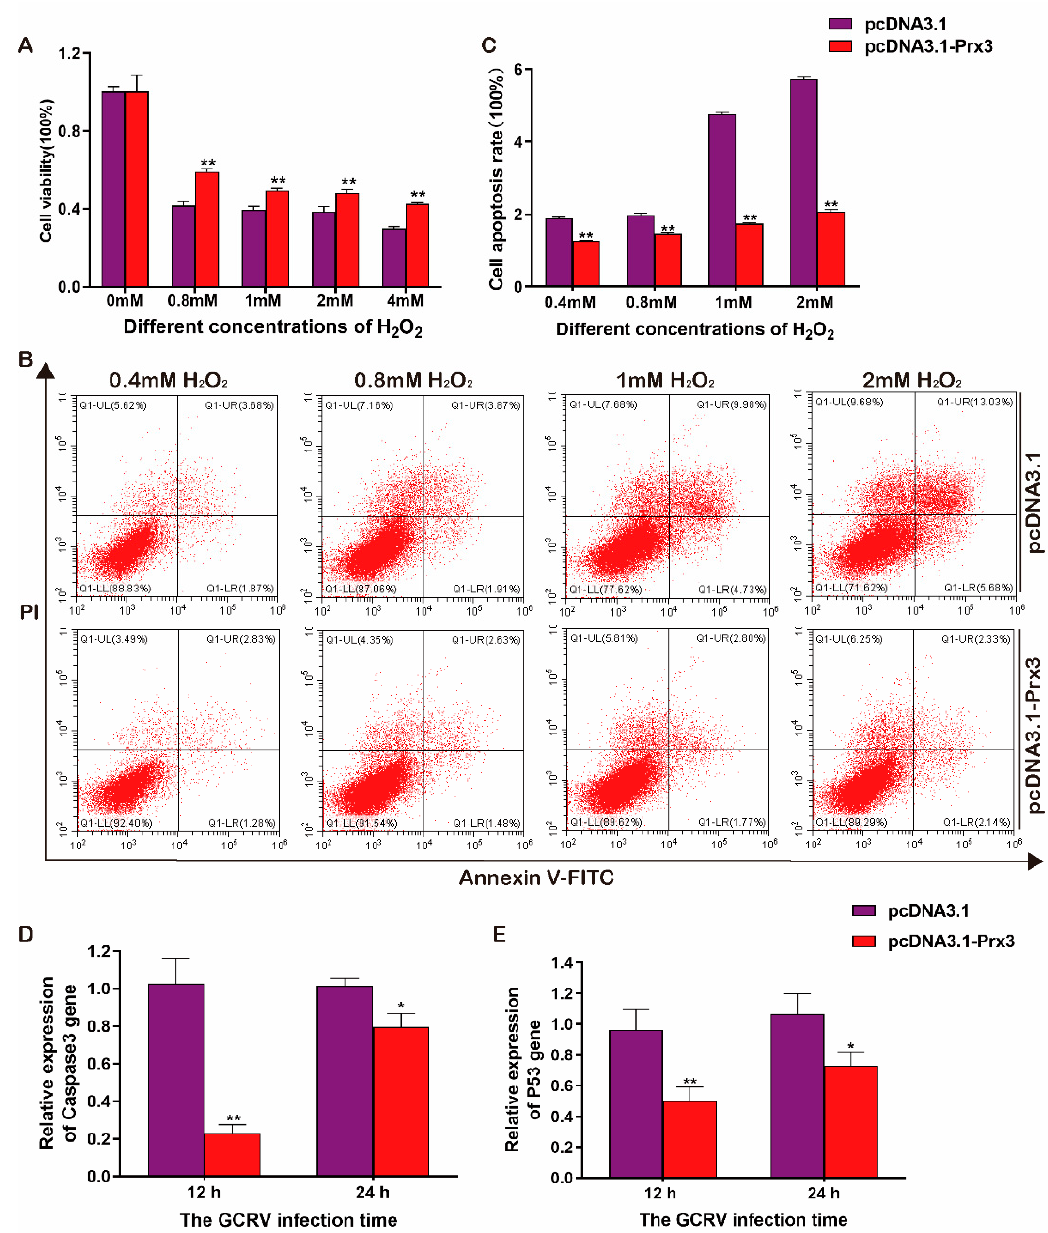
Figure 8. The anti-apoptosis ability of CiPrx3 . ( A ) Cell viability of GCO cells after being treated with different concentrations of H 2 O 2 . ( B ) Flow cytometry assay of cell apoptosis of GCO cells after being treated with different concentrations of H 2 O 2 . GCO cells were transfected with pcDNA3.1- CiPrx3 or pcDNA3.1 and stimulated by different concentrations of H 2 O 2 . Cells were collected to detect cell apoptosis by flow cytometry. ( C ) Calculated cell apoptosis rate of GCO cells after being treated with different concentrations of H 2 O 2 . ( D , E ) The relative mRNA expression level of Caspase 3 and p53. GCO cells were transfected with pcDNA3.1- CiPrx3 or pcDNA3.1 and then infected with GCRV. Cells were harvested at different time points post-infection and the expression of apoptosis-related genes caspase 3 and p53 was detected by RT-qPCR. Data were shown as the mean ± SD ( n = 3). Asterisks represent significant differences (* = p ≤ 0.05, ** = p ≤ 0.01).